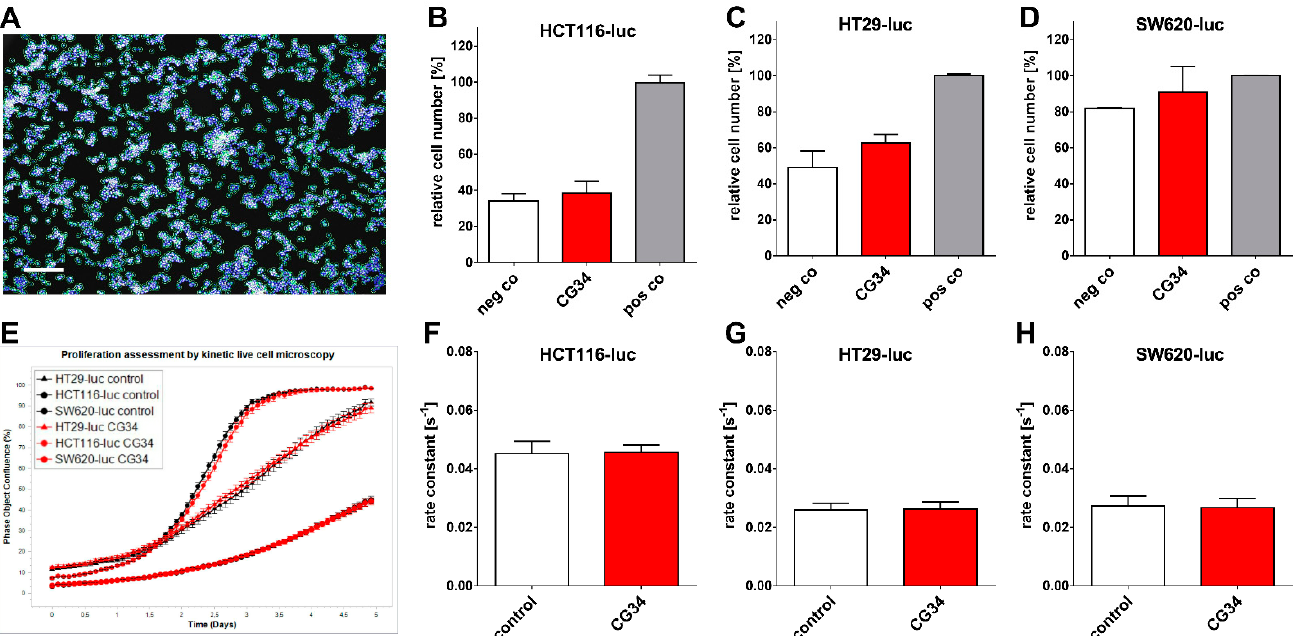
Figure 3. Influence of the chemerin peptide analog CG34 on the proliferation of three luciferase-expressing colorectal carcinoma cell lines (HCT116-luc, HT29-luc, SW620-luc) in vitro as determined versus negative control (low-FCS medium) and positive control (high-FCS medium) by an endpoint assay (IN Cell high-content analysis of DAPI-stained cell nuclei, upper panel A – D ) and versus control (medium only) by a kinetic assay (confluence measurement using Incucyte live-cell microscopy, lower panel E – H ). ( A ) Exemplary image of the pattern recognition algorithm detecting DAPI-stained nuclei (scale bar: 50 µm); quantitative results for ( B ) HCT116-luc; ( C ) HT29-luc; ( D ) SW620-luc. ( E ) Exemplary result of a kinetic live-cell microscopy experiment over five days (black: control cells; red: CG34-treated cells). Quantitative results for ( F ) HCT116-luc; ( G ) HT29-luc; ( H ) SW620-luc. All data represent mean ± SD of n = 3 (DAPI cell nuclei counting) or n = 5 (kinetic microscopy) independent experiments.